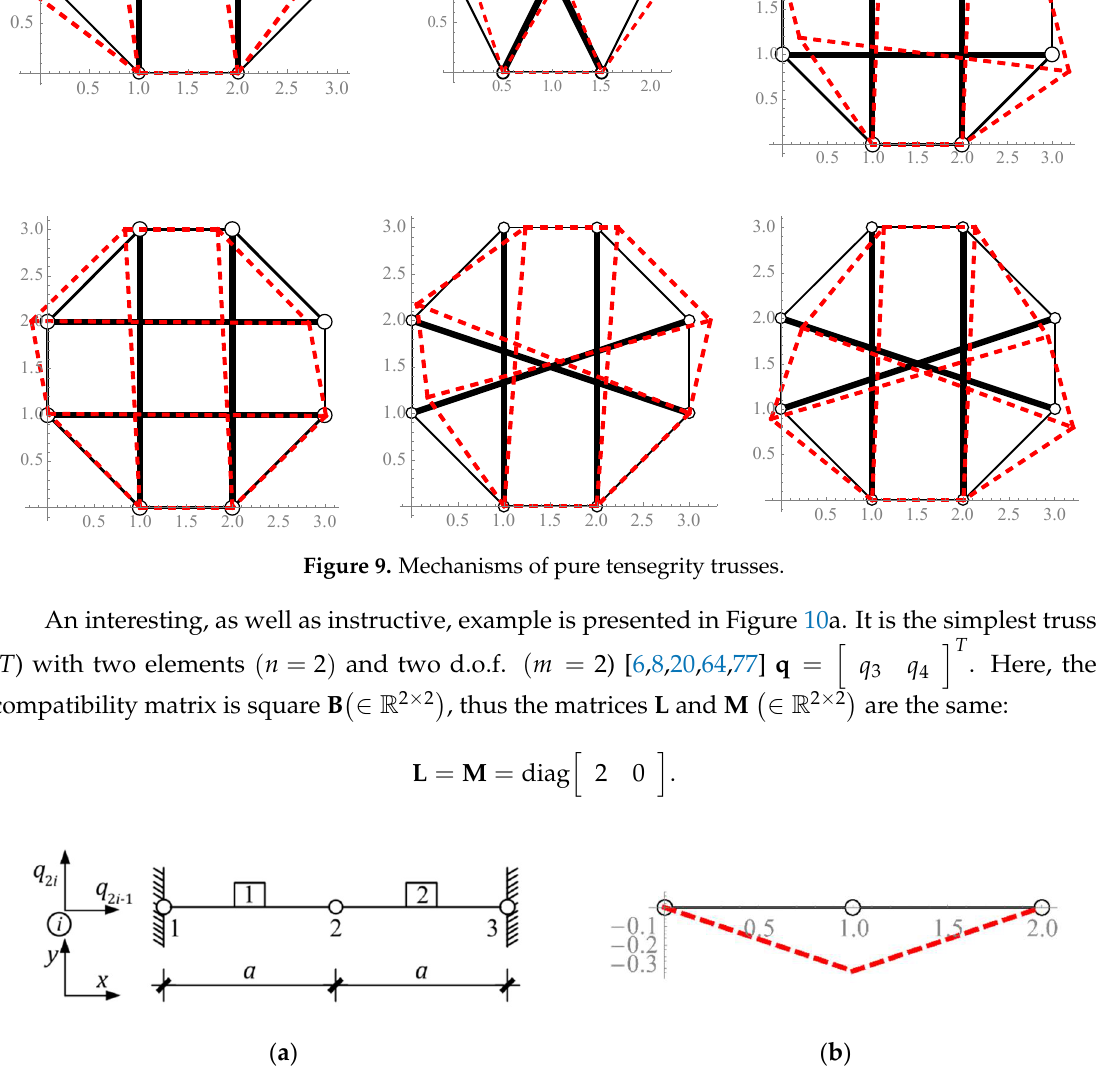
Figure 10. A truss with no tensegrity features: ( a ) geometry, ( b ) mechanism x 2